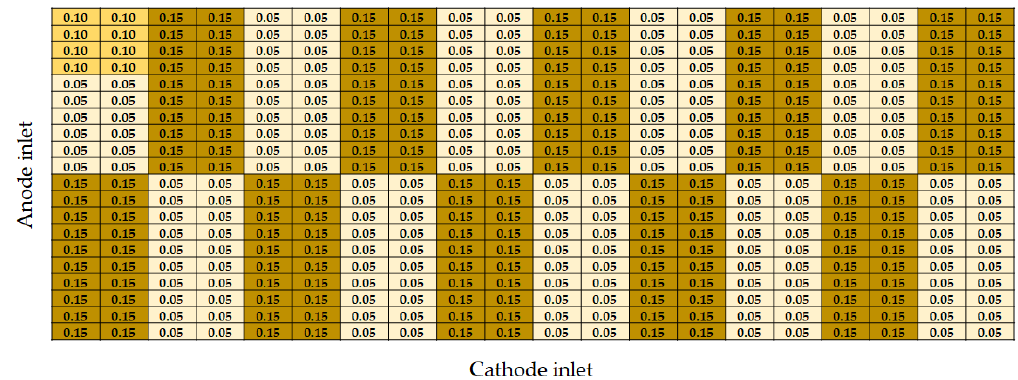
Figure 4. Matrix of σ to optimize cell performance in terms of uneven distribution of temperature and current density.